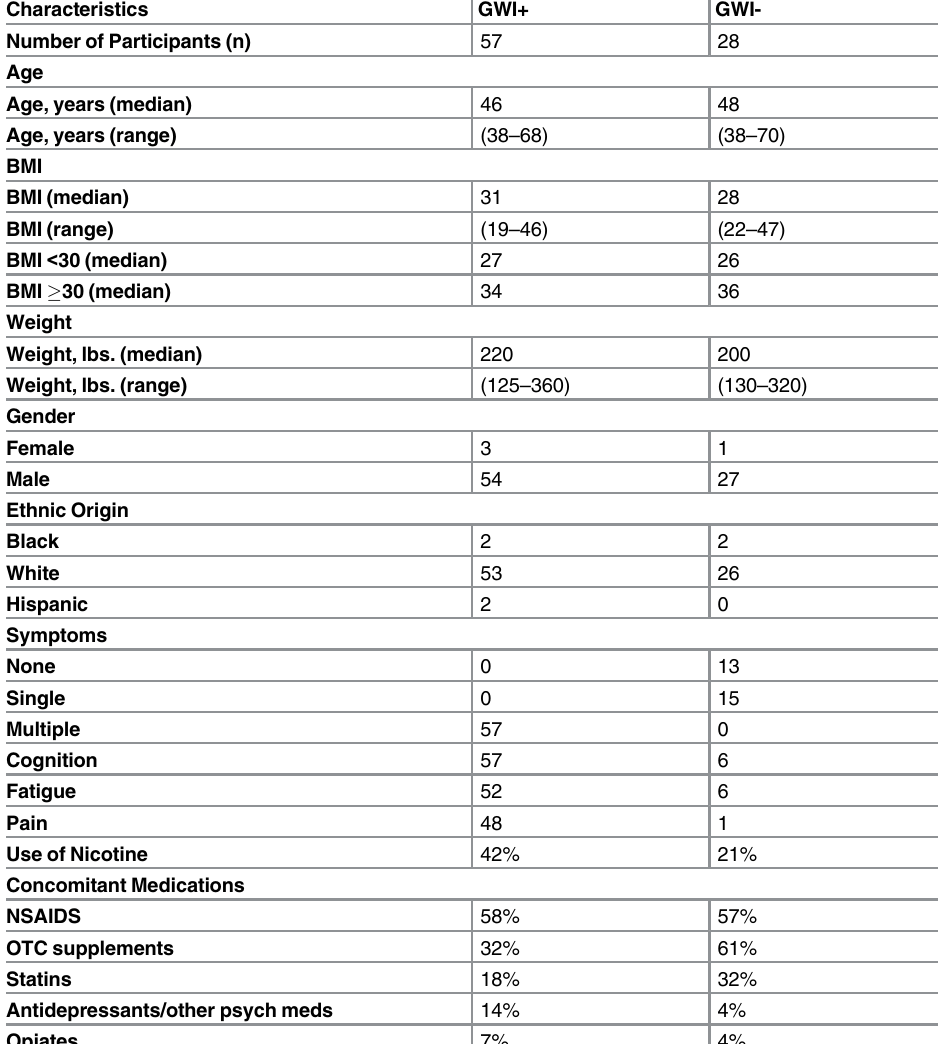
Table 2. Characteristics of Subjects at Time of